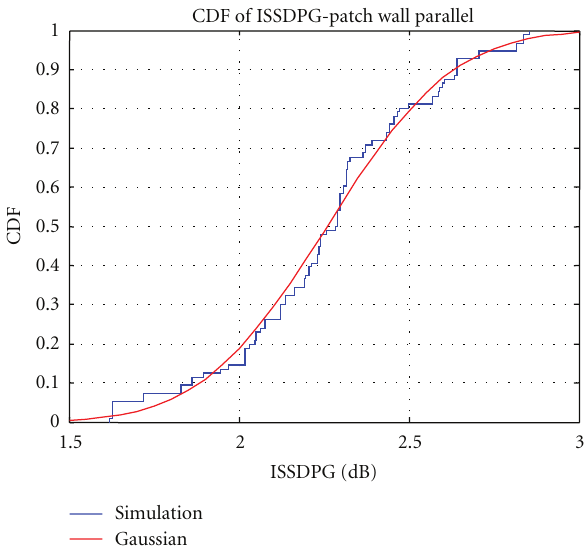
Figure 13: ISSDPG distribution for the patch-wall parallel case.